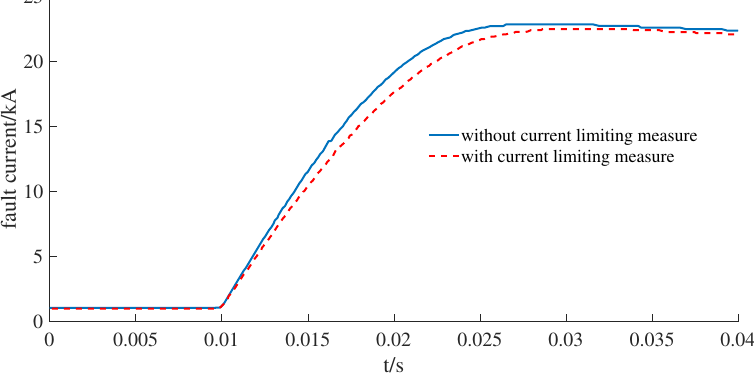
Figure 19. Comparison of DC fault current with/without current limiting